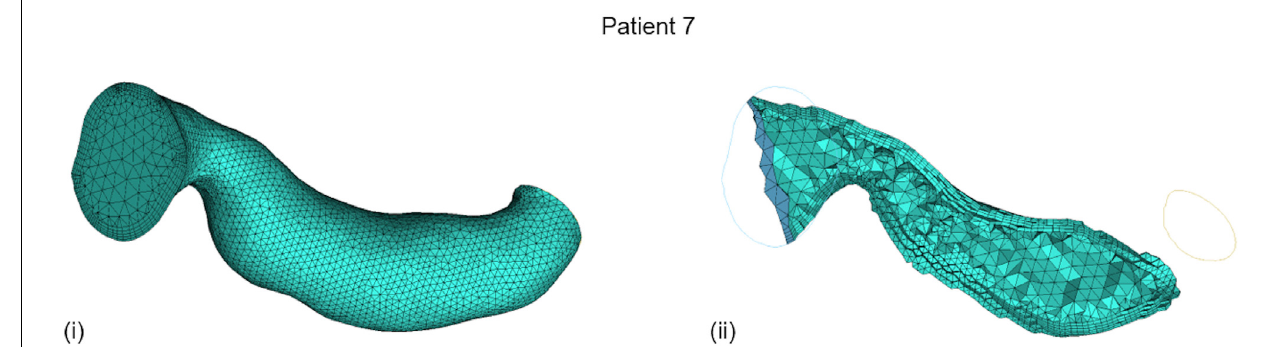
FIGURE 2 | Typical volume mesh for the CFD simulations: (i) the mesh elements on the wall and on the inlet cross-section, and (ii) the tetrahedral elements inside the volume and the prismatic layers near the wall on a cut plane can be